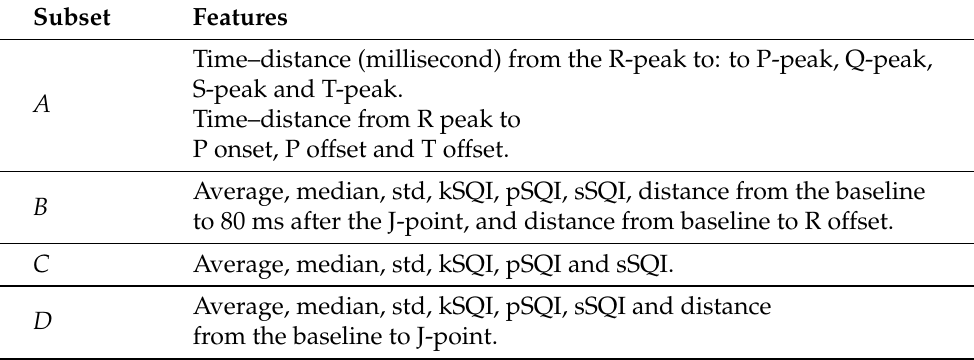
Table 1. Different subsets of features used for prediction. A : corresponds to the use of distance metrics between ECG beat peaks, B : corresponds to the use of statistical measures SQIs and distance metrics, C : only considers statistical metrics and SQIs, D : has a combination of statistical measures, SQIs and distance measures at two points after the